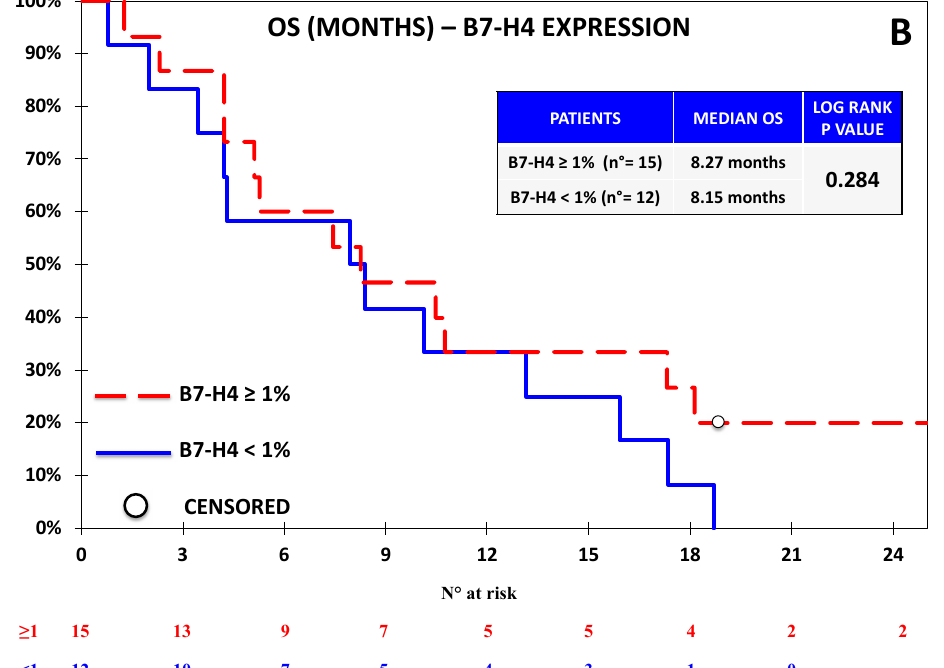
Figure 8. Kaplan–Meier curves for RECIST-PFS ( A ) and OS ( B ) based on the expression of B7-H4 defined as ≥ 1% vs. <1% in the Chemotherapy Cohort. No significant difference in terms of PFS or OS was observed on the basis of B7-H4 expression.